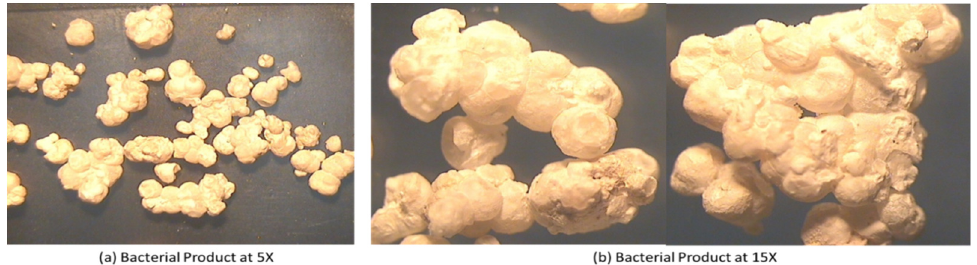
Fig. 4 (a-b): Stereo Micrographs of Bacterial Product